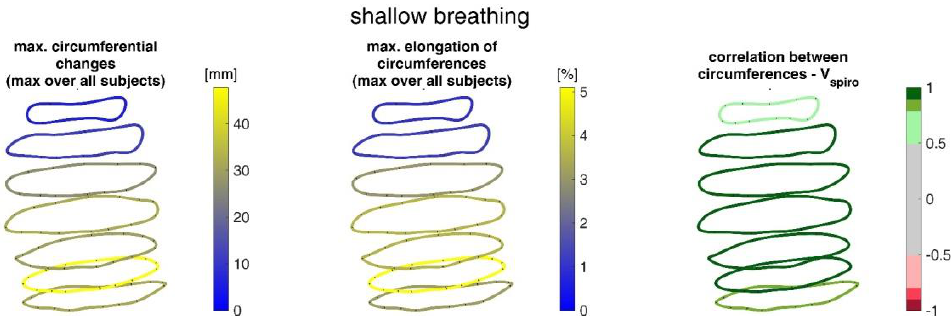
Figure 15. Illustration of the maximal circumference changes amongst all subjects during shallow breathing (left), the corresponding circumference elongation (center), and the mean corresponding correlation of circumferences with spirometer volume V spiro of all subjects during shallow breathing are shown (right).